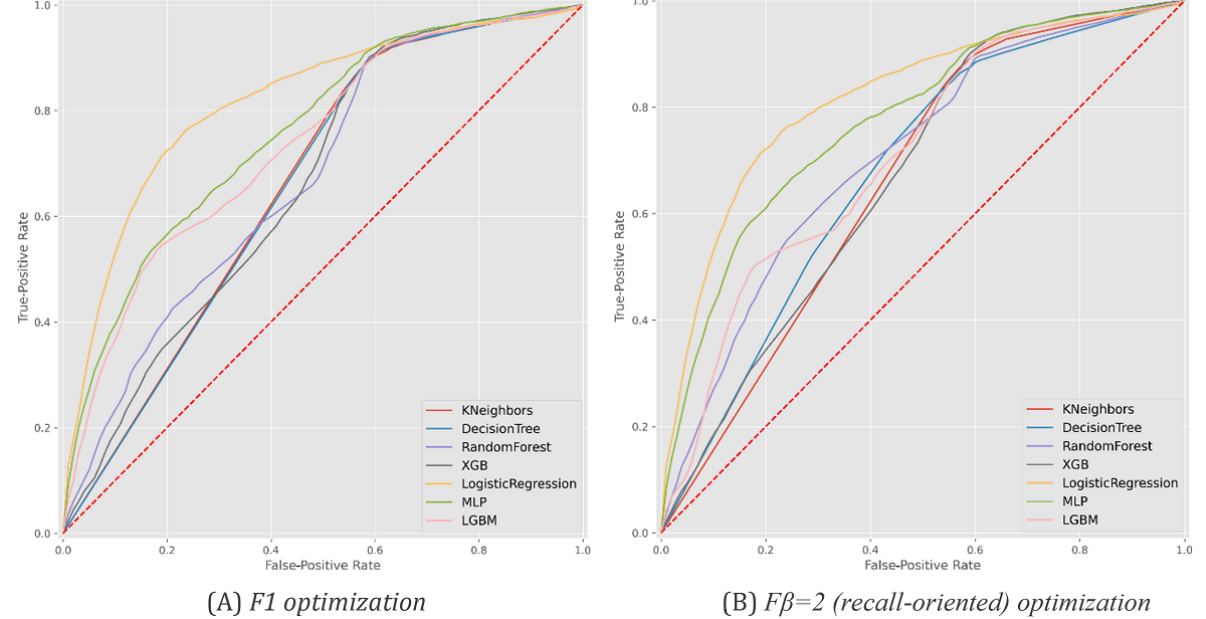
Figure 5. Receiver operating characteristic curves with the predictive behavior of the selected classifiers in asserting hospitalization needs at the time of SARS-CoV-2 testing. XGB: XGBoost, MLP: multilayer perceptron, LGBM: